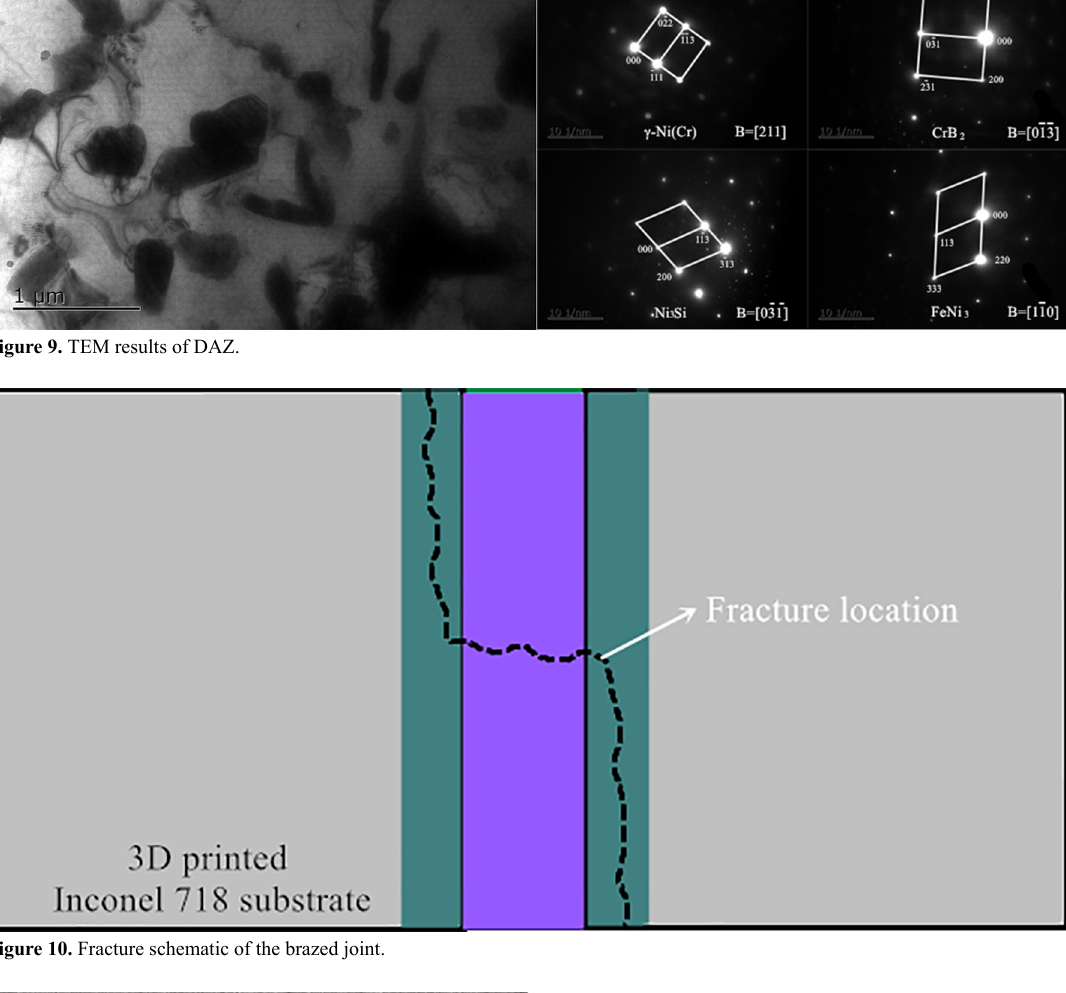
Figure 10. Fracture schematic of the brazed joint.